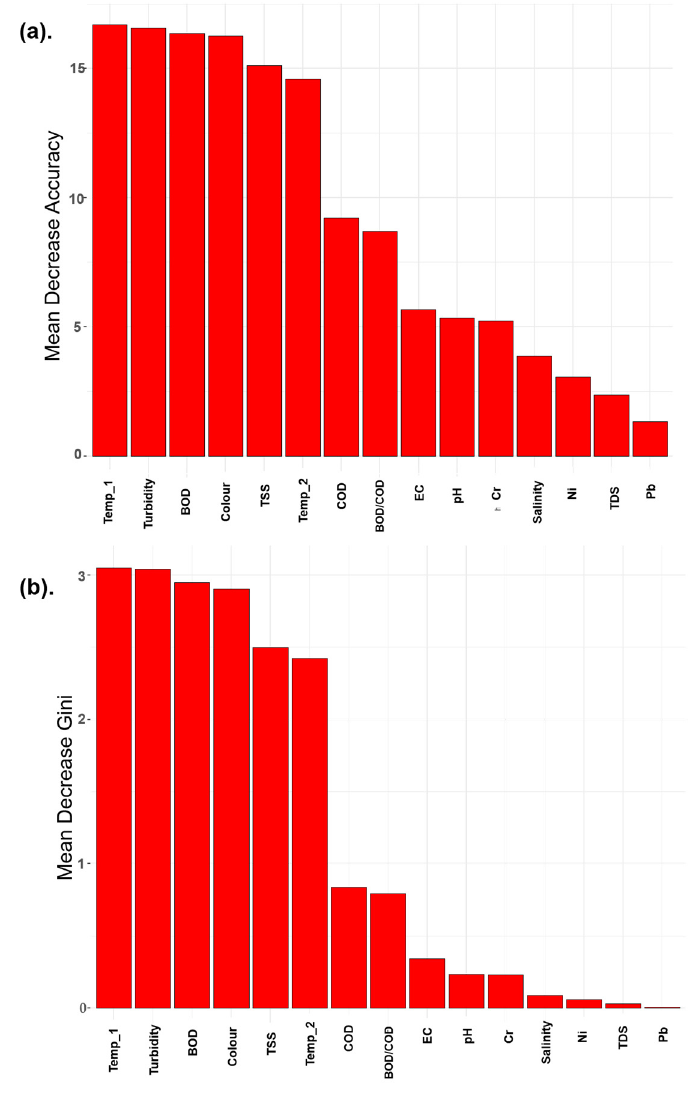
Figure 3. Bar-plots showing ( a ) the mean decrease in accuracy of water quality parameters sorted in terms of their importance; ( b ) the mean decrease in Gini of water quality parameters sorted in terms of their importance.